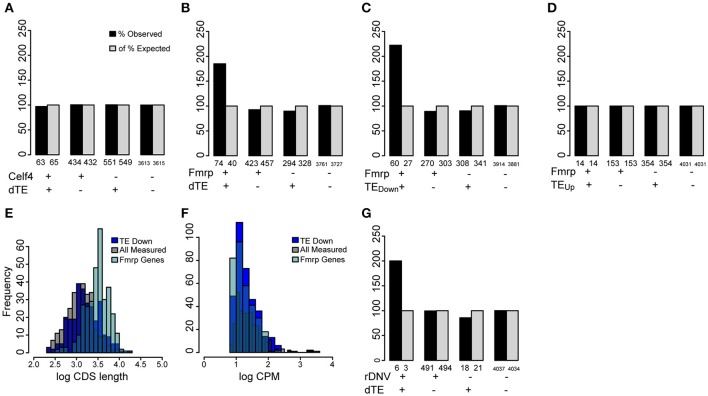
Regulated transcripts are disproportionately targets of FMRP. (A) Bar chart illustrating percent of genes overlapping between the translationally regulated genes (significantly changed in TE: dTE+) and published CELF4 targets, compared to expectation by chance. Numbers of observed genes overlapped (n = 63), does not differ from chance (Fisher's exact Test, p > 0.1). (B) FMRP targets significantly overlapped (p < 7.7e-08) with genes showing a change in TE (dTE genes, n = 71 genes overlapped). (C) Specifically, the genes with TE downregulated were found on the FMRP target list ~3-fold more than expected by chance (p < 3.2e-10, Odds Ratio 2.97, 95% CI:2.24-Inf), (D) while the upregulated genes were not. (E) Distribution of CDS lengths (in log10) for measured FMRP targets shows they are substantially longer than a random sample of measured genes. The translationally regulated genes (dTE) do not share this bias. (F) All three gene categories show similar levels of transcript abundance in the neural cultures. (G) Genes associated with autism by analysis of rare de novo variation also modestly overlapped with translationally regulated genes (p < 0.04).